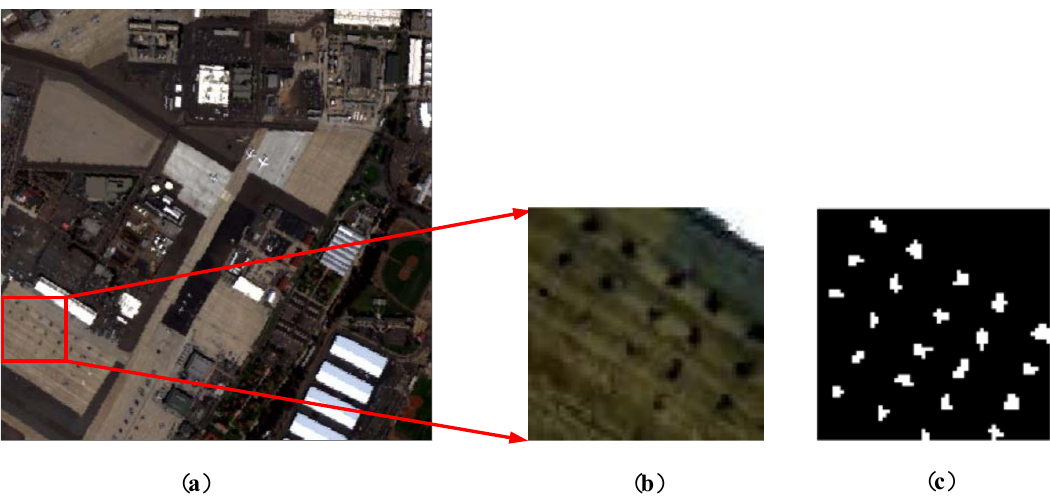
Figure 6. Descriptions of AVIRIS–II dataset. ( a ) False color image of the whole scene; ( b ) false color image of the detection area; ( c ) ground-truth of AVIRIS–II dataset.